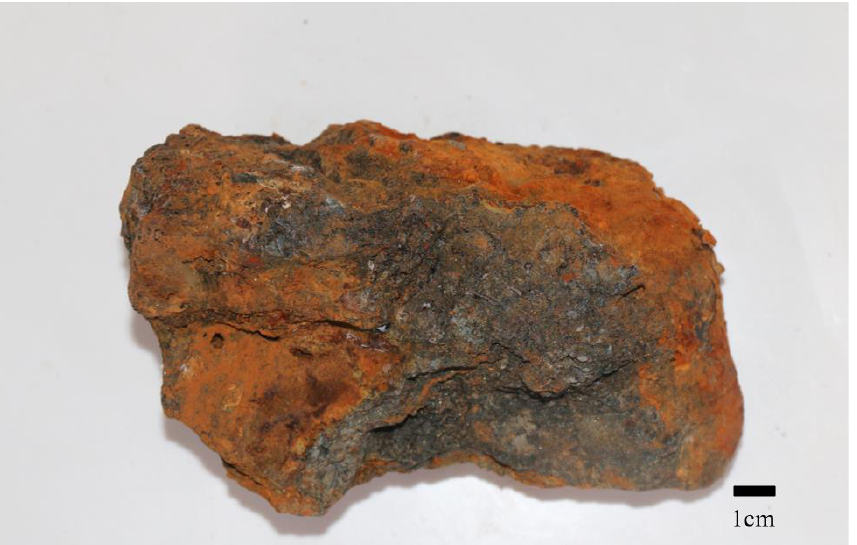
Figure 8. Interior photograph of the hydrothermal sulphide.